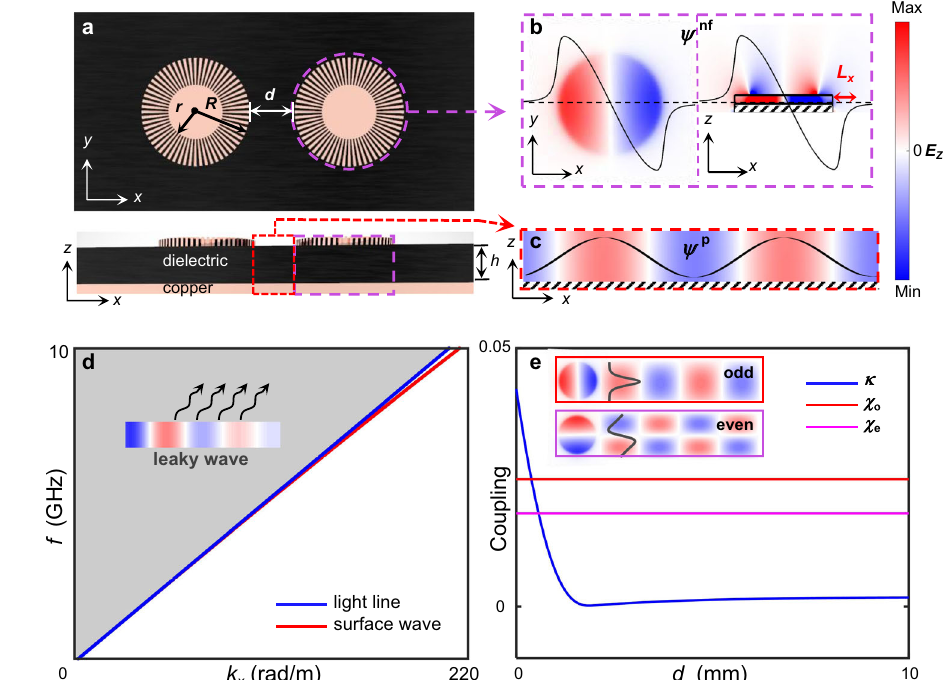
Fig. 2 | Designer-plasmonic realization of the radiative APT system. a The top view and the front view of the designer-plasmonic APT system. It consists of two DSPRs with a distance d , encircled by the background horizontally. The purple dashed line denotesa singleresonator composedof three layers. The toplayeris a groove-structured copperplate, standing on a dielectric substrate with thecopper coating on its bottom. The background is also constructed with the dielectric substrate coated with copper plating. b The E z component of the simulated DSPR